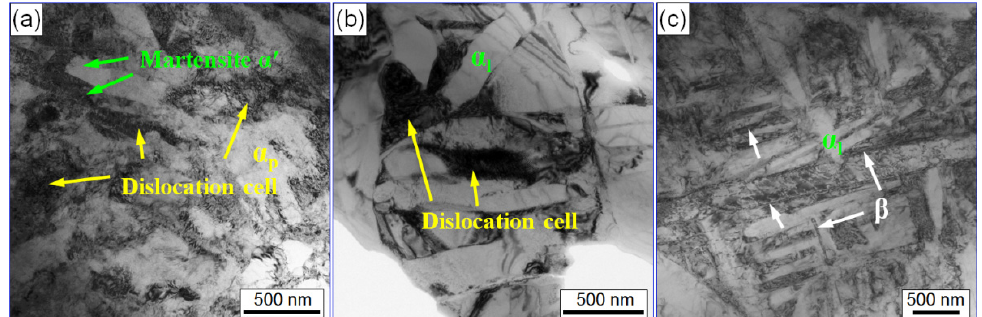
Figure 14. TEM images of the compressed specimens for ( a ) equiaxed microstructure, ( b ) basket- weave microstructure and ( c ) widmannstatten microstructure under 50 A/mm 2 .